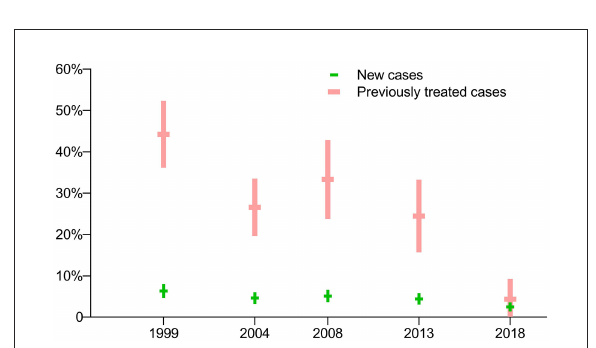
FIGURE3 Prevalence of rifampin-resistant TB: breakdown by treatment history in five periodic